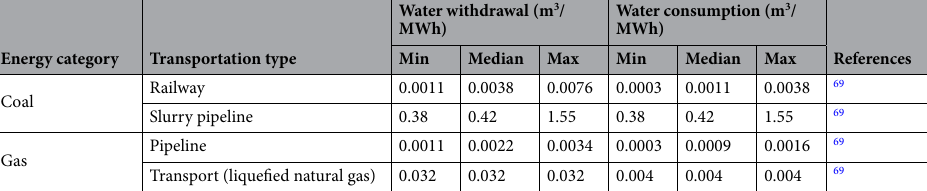
Table 5. Water intensity data for fossil fuels transportation in the upstream